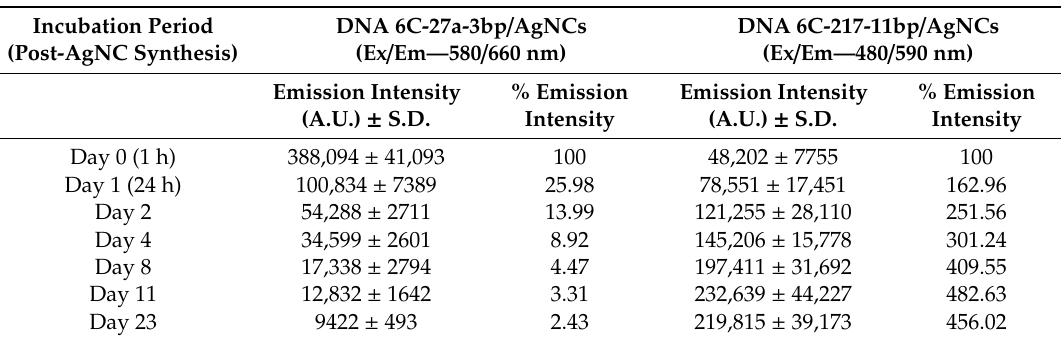
Summarized result of emission intensities of DNA 6C-27a-3bp / AgNCs and DNA 6C-217-11bp / AgNCs after designated incubation time post-synthesis of DNA / AgNCs. %